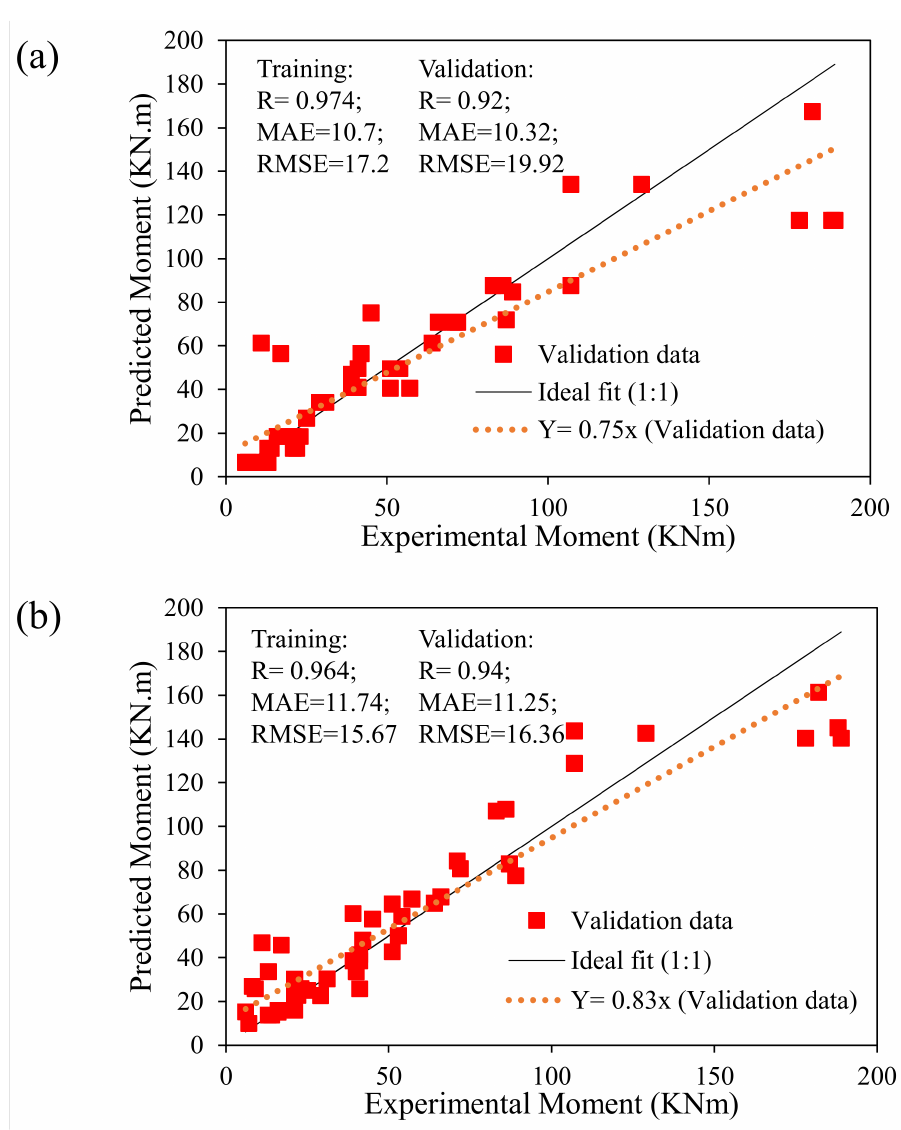
Figure 4. Prediction performance of the developed model: ( a ) DT, and ( b )